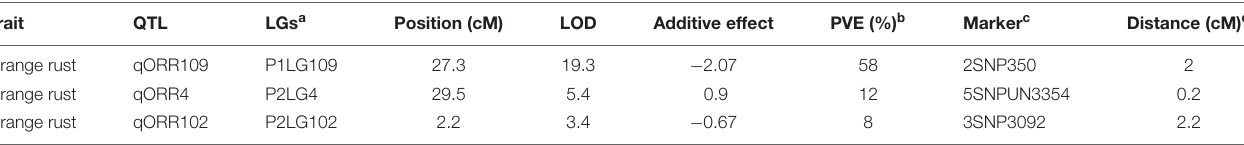
TABLE 4 | Phenotypic effects of quantitative trait loci (QTL) allele combinations on orange rust resistance in the F 1 population from the cross CP95-1039 × CP88-1762. qORR109,qORR4,qORR102 a Marker genotype b No of progeny Disease resistance (se) c Reduction in disease severity (%) d − , + , − Ho.,He.,Ho.